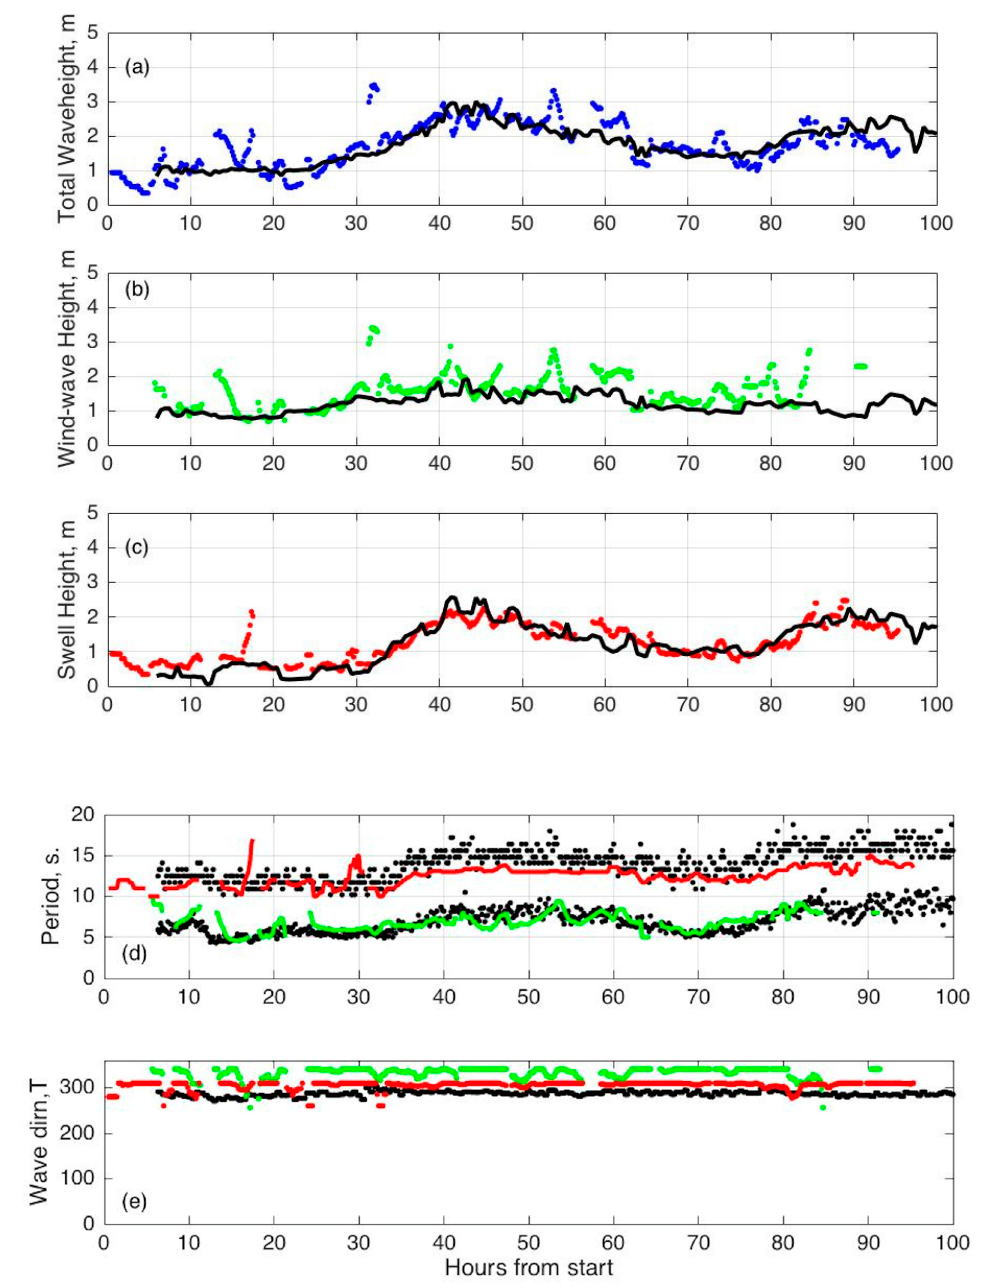
Figure 11. Wave parameters parameters plotted vs. time. For ( a – c ) half-hourly from spectral data and for ( d , e ) hourly from standard meteorological data. Buoy parameters are plotted in black. Radar parameters are plotted as follows: ( a ) Total waveheight: Radar (blue), ( b ) Wind-wave height (green) ( c ) Swell waveheight (red), ( d ) Wave period: Wind-wave (green), Swell (red) ( e ) Wave direction: Wind-wave (green), Swell (red). Start time: 12:00 a.m., 12 March 2015.